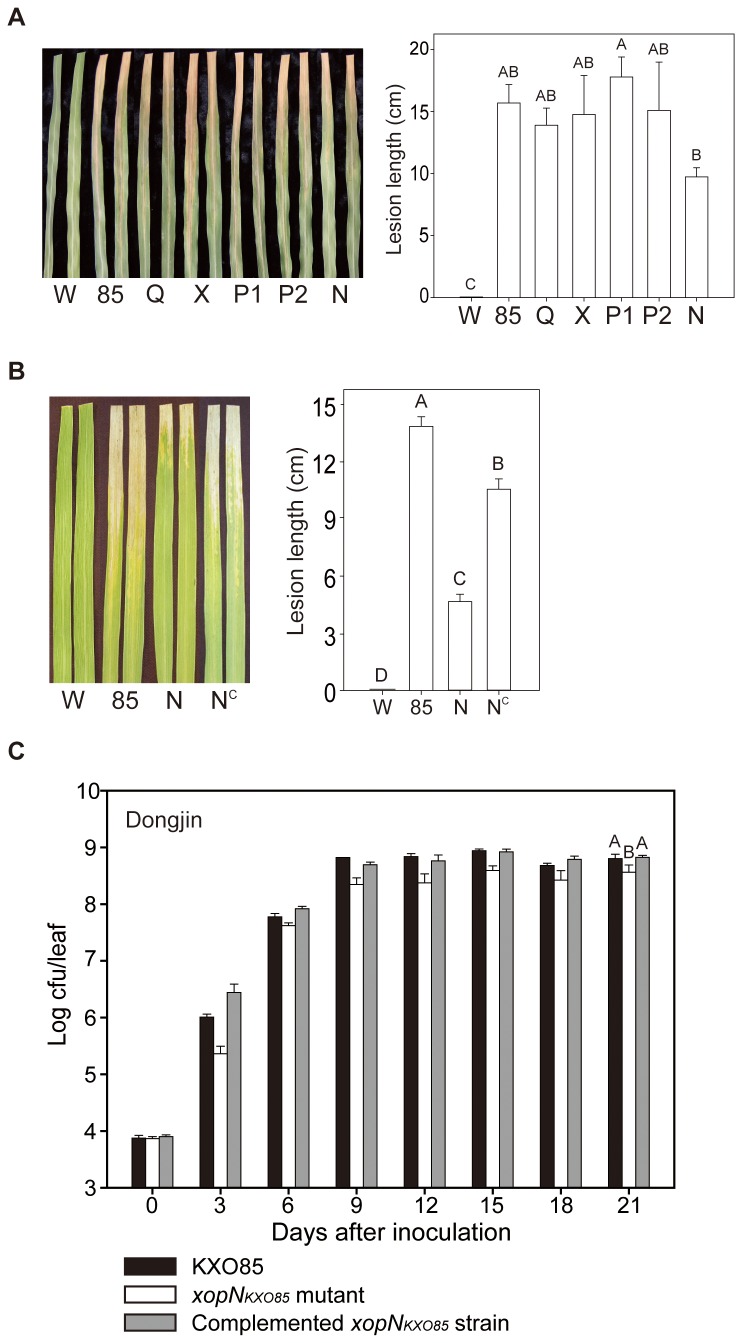
Pathogenicity test for xop mutants of Xoo KXO85 in rice.
A. Disease severity of each xop mutant in 3-month-old rice leaves. W, water; 85, wild-type KXO85; Q, KXO85 xopQ
KXO85::EZ-Tn5; X, KXO85 xopX
KXO85::EZ-Tn5; P1, KXO85 xopP1
KXO85::EZ-Tn5; P2, KXO85 xopP2
KXO85::EZ-Tn5; N, KXO85 xopN
KXO85::EZ-Tn5. B. Disease severity of the xopN
KXO85 mutants in the flag leaves of rice grown in a paddy field. W, water; 85, KXO85; N, KXO85 xopN
KXO85::EZ-Tn5; and NC, KXO85 xopN
KXO85::EZ-Tn5 (pML122G2). Photographs were taken and lesion lengths were determined 21 days after inoculation. Vertical error bars indicate the standard deviations (SD). The data are the averages of 12–15 replicates for each treatment. Columns and lines not connected by the same letter are significantly different (P<0.05) as determined by a one-way ANOVA (P<0.001) followed by post hoc Tukey HSD analysis. C. Bacterial growth patterns of the KXO85, xopN
KXO85 mutant, and complemented xopN
KXO85 mutant strains in flag leaves of wild-type Dongjin. The data are shown as the average values for three replicates; vertical bars indicate the error ranges (±SD). The bacterial populations were assessed every 3 days after inoculation. Different letters at day 21 indicate significant differences (P<0.05) as determined by a one-way ANOVA (P<0.001) followed by post hoc Tukey HSD analysis.